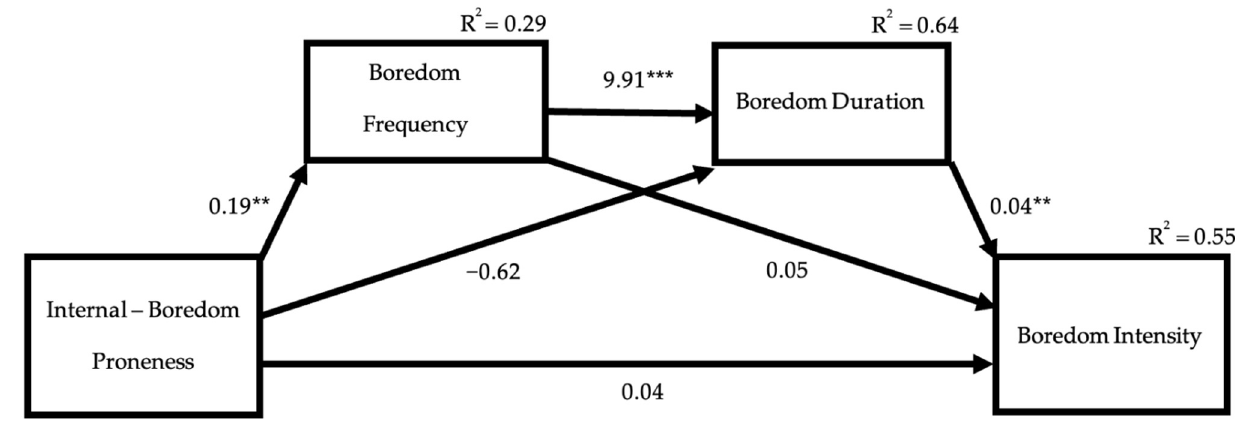
Figure 1. Serial mediation of boredom frequency and boredom duration on the association between the internal factor of boredom proneness and boredom intensity. ** p < 0.01, *** p < 0.001.